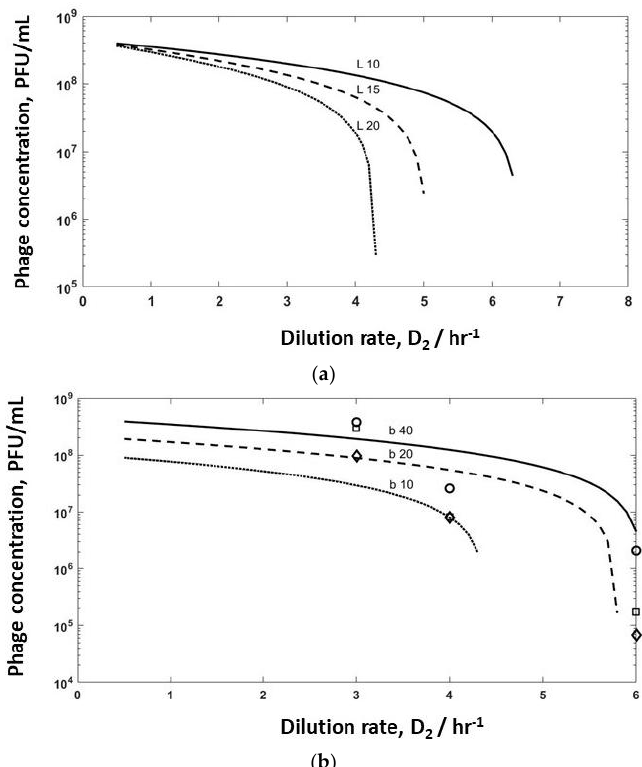
Figure 6. Simulation results showing the effect of (a) lag time on phage washout; a burst size of 40 and adsorption rate of 3.6 × 10 −11 L hr −1 was used for the simulations; (b) burst size on phage titres and washout of phages in reactor R2: the dotted line represents the results of the numerical simulations using adsorption rates of 9 × 10 −11 L hr −1 and a burst size of 10, the dashed line represents the results of the numerical simulations using adsorption rates of 7 × 10 −11 L hr −1 and a burst size of 20, the solid line represents the results of the numerical simulations using adsorption rates of 3.6 × 10 −11 L hr −1 and a burst size of 40. Open squares (□) correspond to phages produced in R2 with R1 operated at D 1 = 0.4 hr −1 ; open round circles (o) correspond to phages produced in R2 with R1 operated at D 1 = 0.5 hr −1 ; open diamonds ( ) correspond to phages produced in R2 with R1 operated at D 1 = 0.6 hr −1 . The other simulation parameters that were used for all of the simulations were: C 1 = 1.1 × 10 10 CFU L −1 , S 1 = 1.5 g L −1 and a lag time of 10 min.